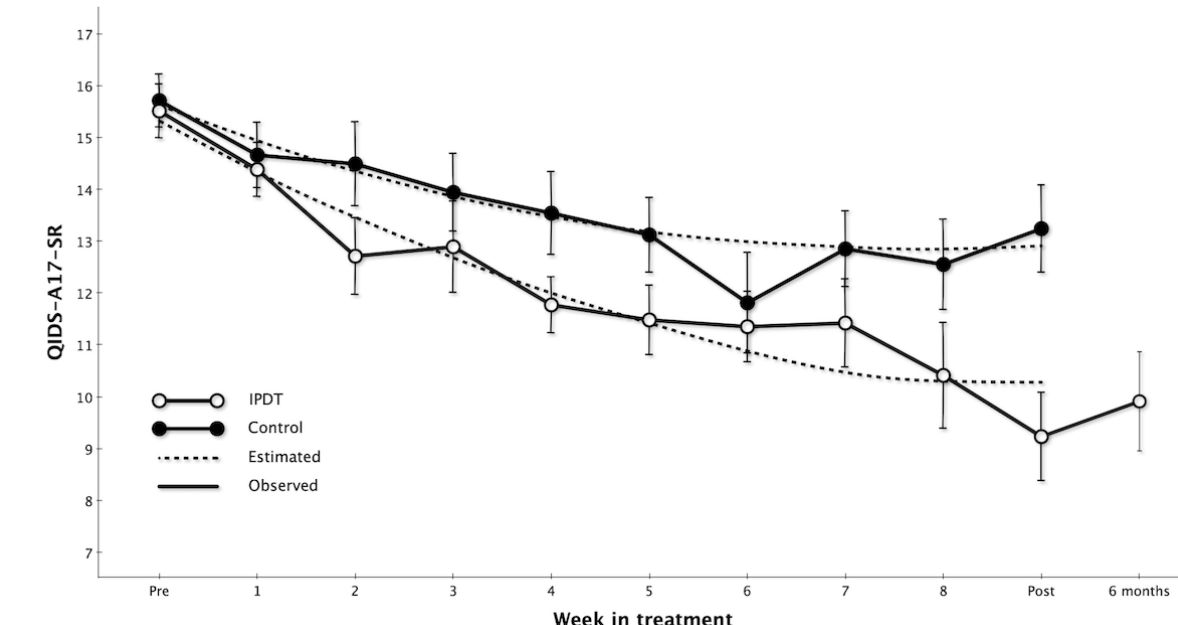
Figure 3. Weekly mean scores on the QIDS-A17-SR (Quick Inventory of Depressive Symptomatology for Adolescents). IPDT: internet-based psychodynamic